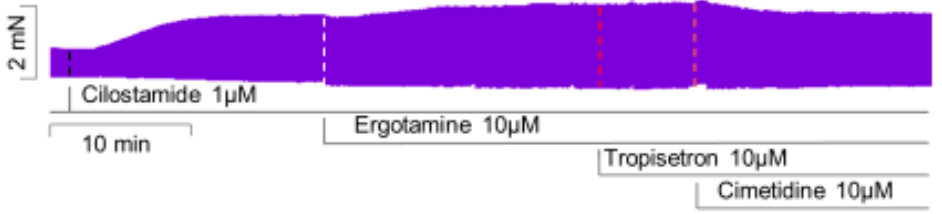
Figure 7. Ergotamine increases force in human atrium: original recording of the effect of 10 µ M ergotamine (Ergo), 10 µ M tropisetron (Tropi) and 10 µ M cimetidine (Cime) in the presence of 1 µ M cilostamide (Cilo) on HAP.